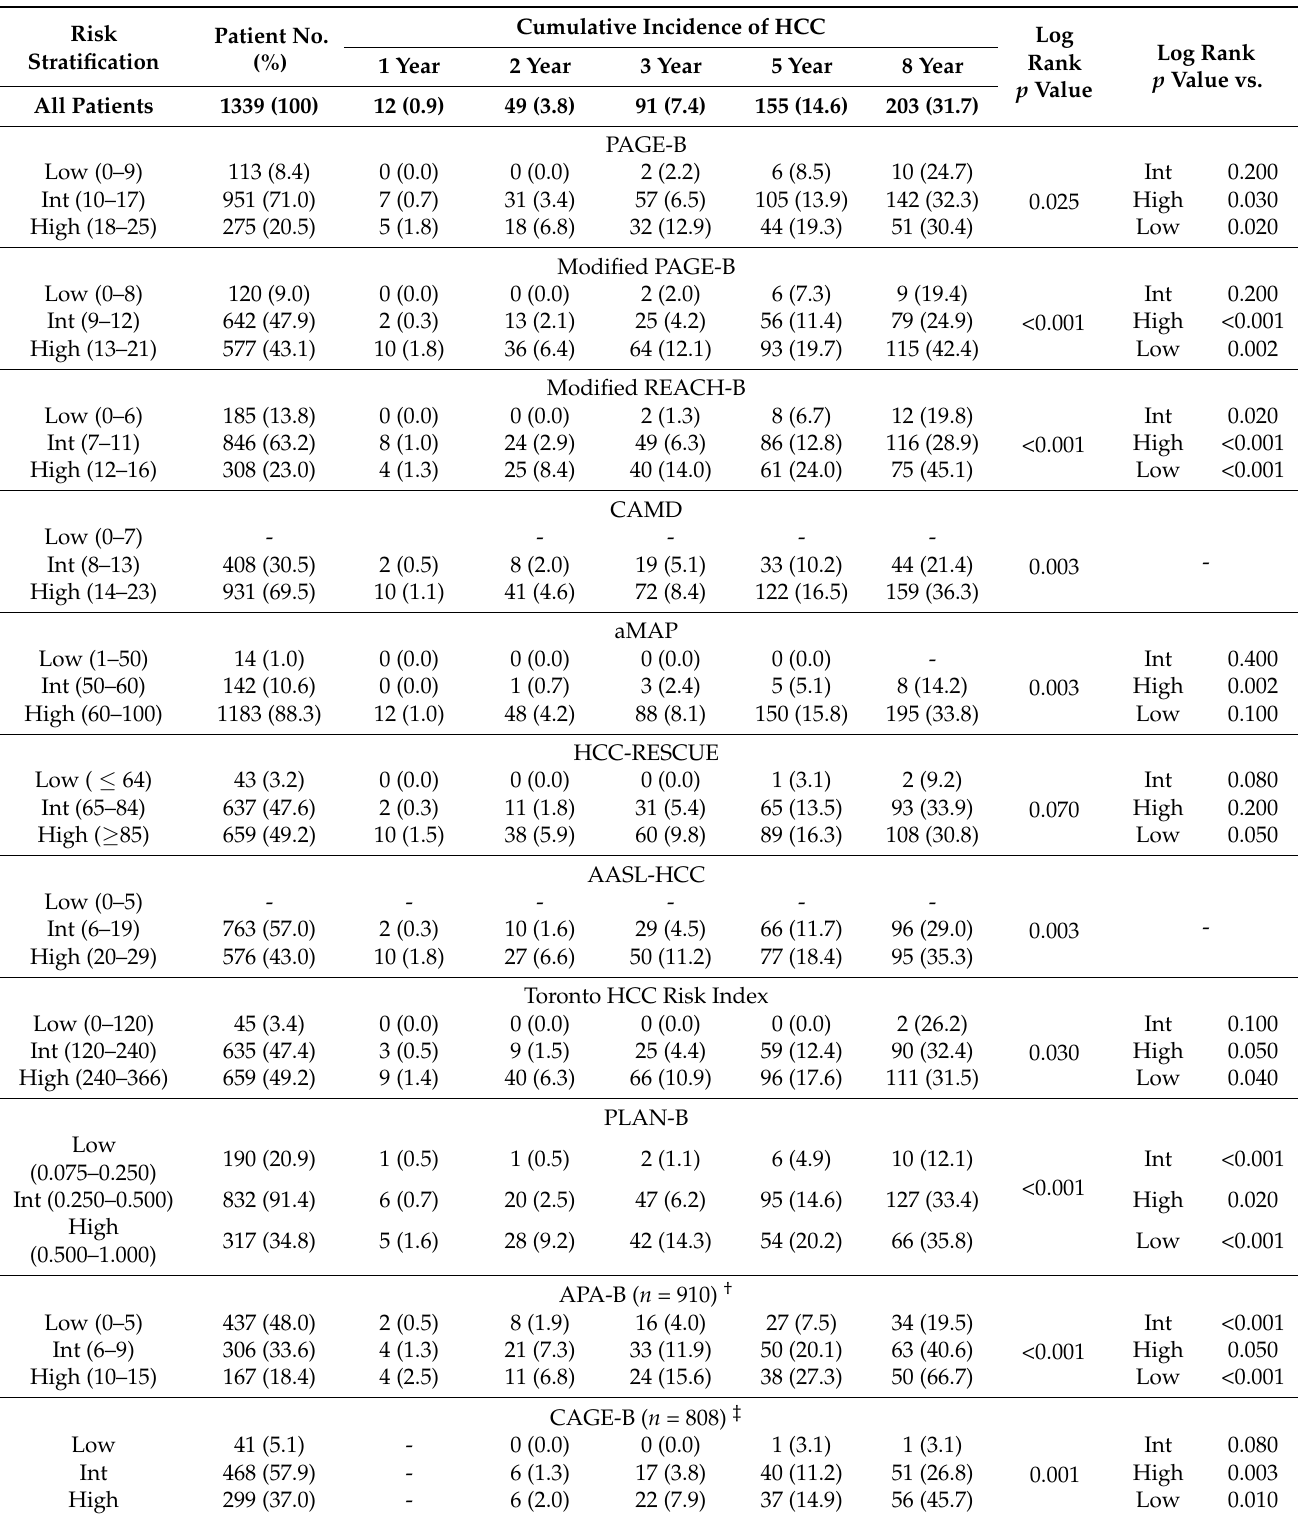
Table 5. Cumulative incidence of HCC development in patients with treatment-naïve chronic hepatitis B according to the risk stratification by each risk prediction